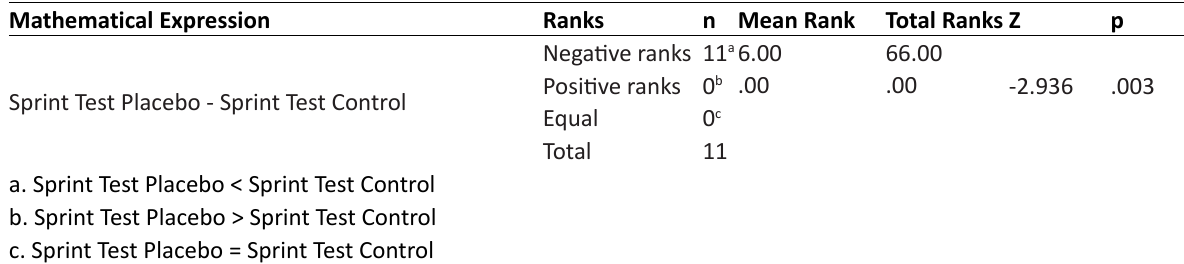
Table 7: Wilcoxon Signed Rank Analysis Results of Caffeine Application (Sprint Test) Mathematical Expression